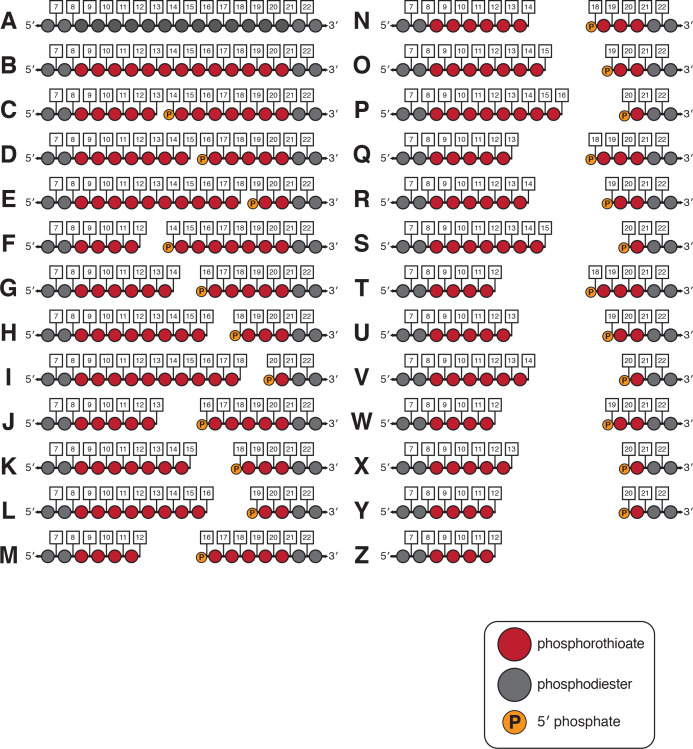
Non-target-strand variants used in gap-dependence experiments.Nucleotides 7–22 of the NTS are shown for each variant. A red circle indicates a phosphorothioate linkage. A gray circle indicates a phosphodiester linkage. A 5′ phosphate was placed on all PAM-distal NTS fragments to recapitulate the end chemistry left by the RuvC-catalyzed hydrolysis reaction.